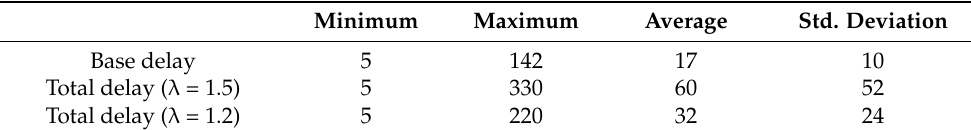
Table 1. Delay statistics of the update packages.